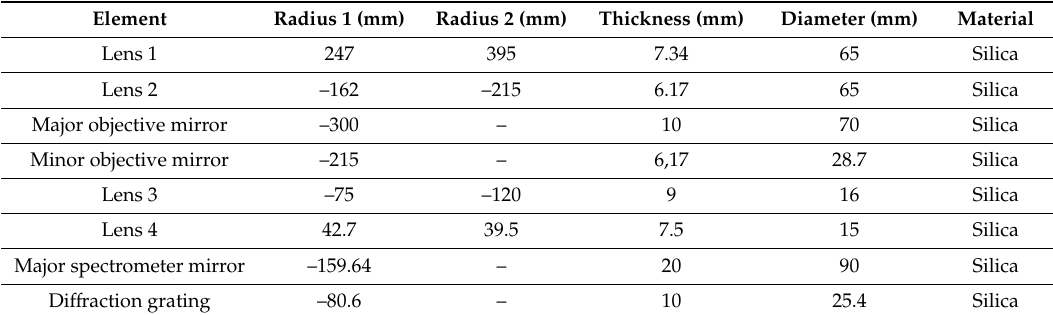
Table 1. Major parameters of O ff ner imaging hyperspectrometer.